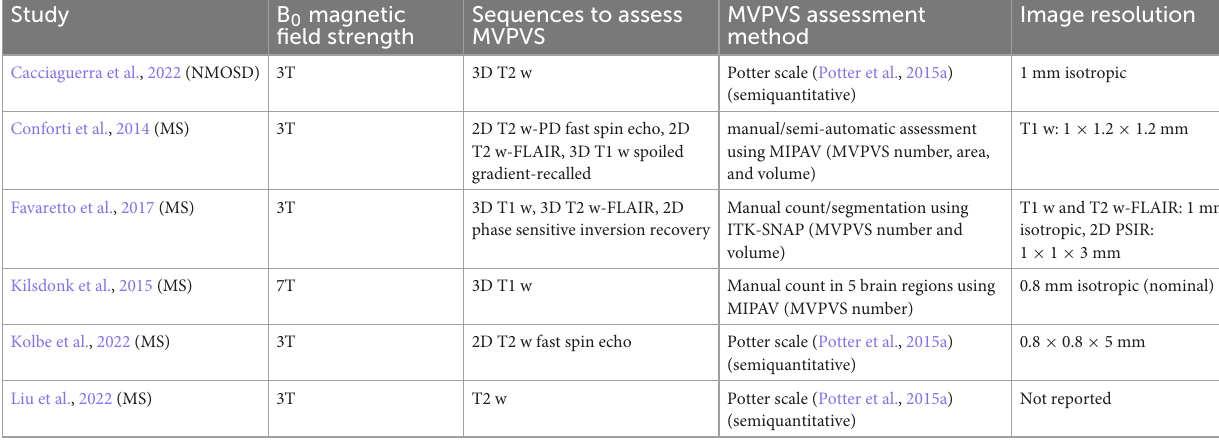
TABLE 1 Employed magnetic resonance imaging (MRI) parameters of studies included in the meta-analysis.